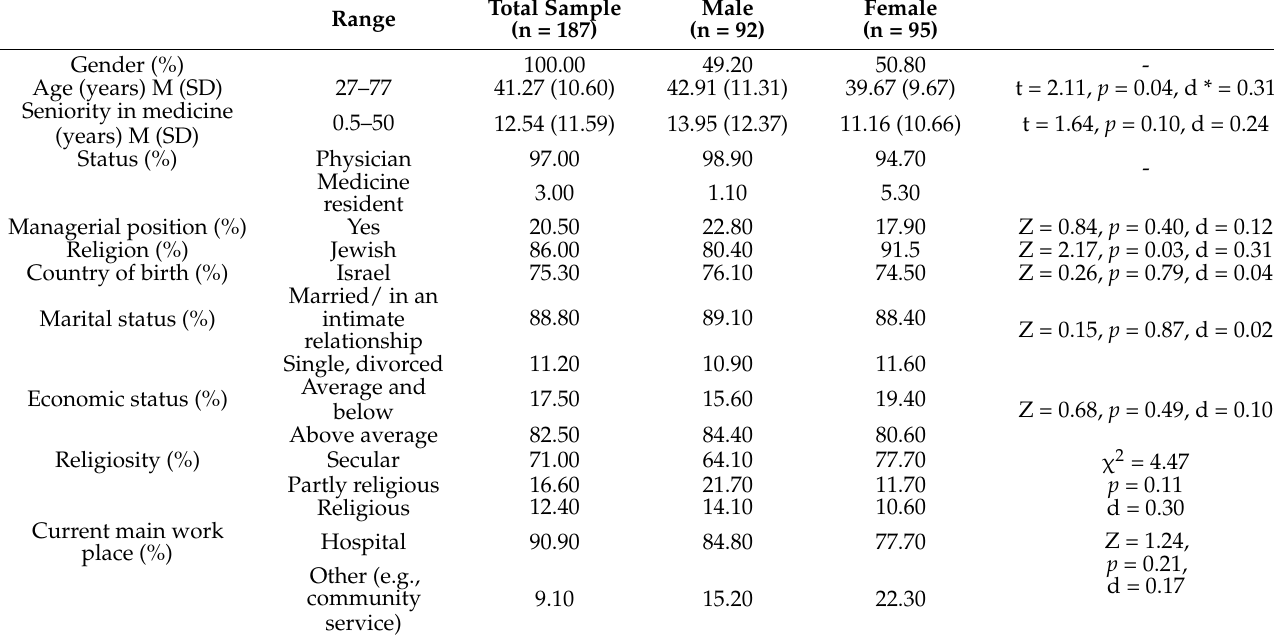
Table 1. Participants’ demographic characteristics by